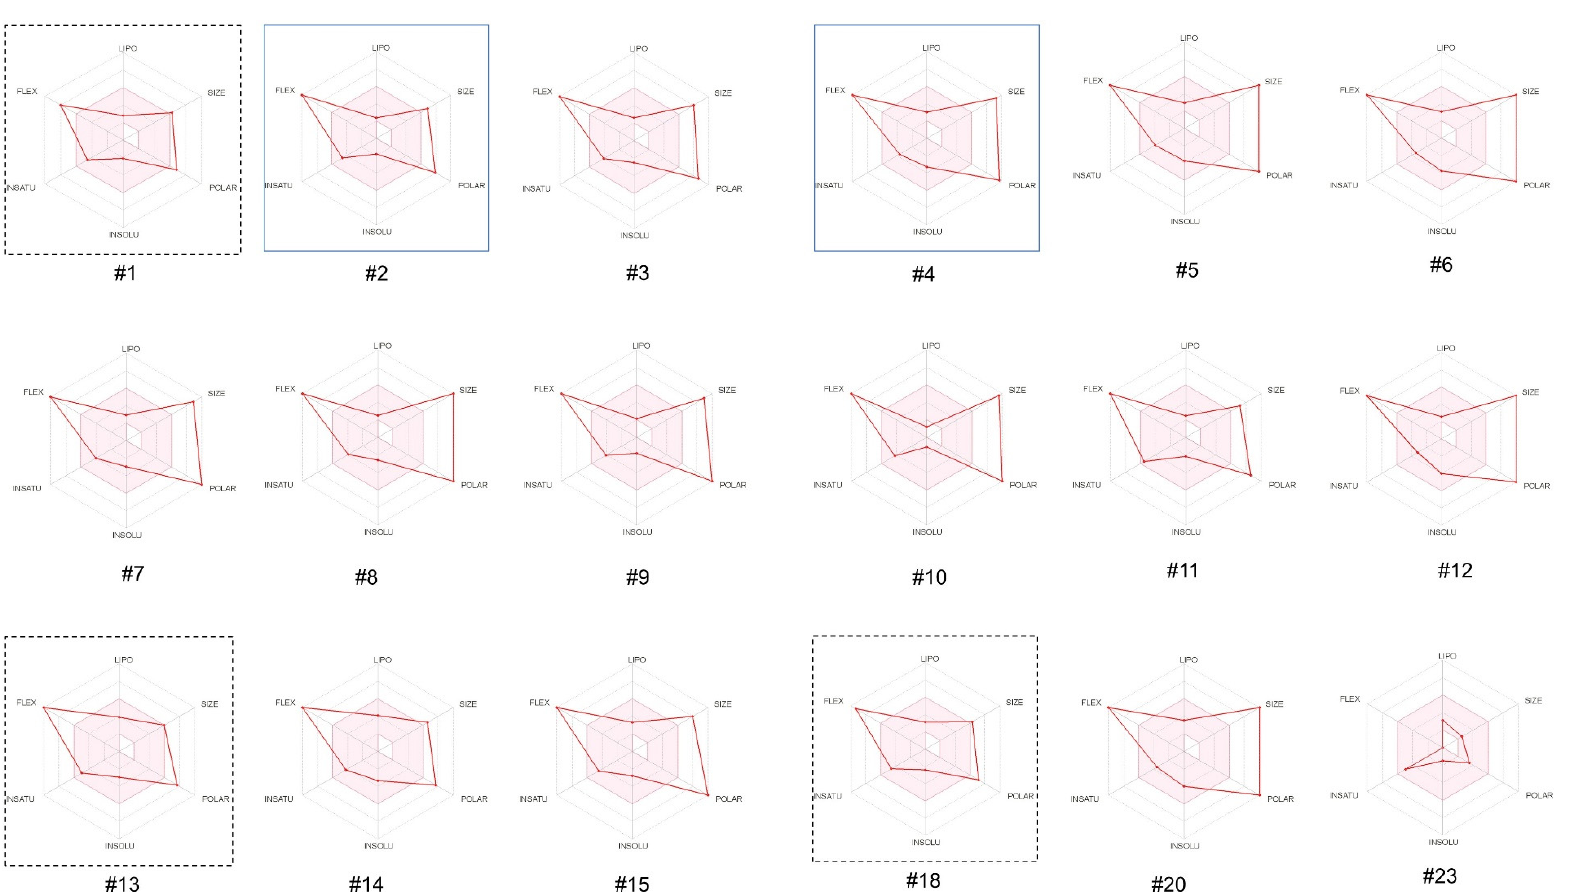
Figure 1. Representative bioavailability radar plots of the opioid peptides and caffeine (compound #23). The colored zone is the suitable physicochemical space for oral bioavailability. LIPO, lipophilicity; SIZE, molecular weight; POLAR, polarity; INSOLU, insolubility; INSATU, insaturation; FLEX, flexibility. Compounds in dashed squares had moderate bioavailability scores (0.55). Compounds #2 and #4 are β -casomorphin-5 and β -casomorphin-7, respectively. Refer to Table 2 for the chemical names and identities corresponding to the other compounds in this figure.